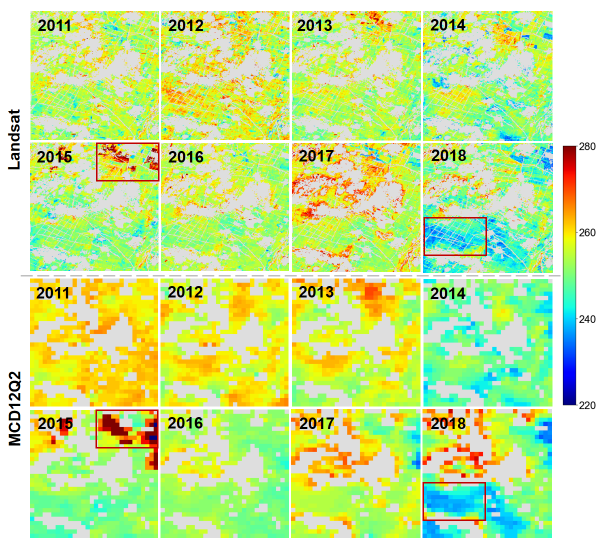
Figure 12. Comparison of the Landsat derived maturity date and the MODIS derived mid-green-down date from 2011 to 2018. The selected scene is case 1 in Fig. 11. Red boxes are highlighted regions where these two products have a noticeable